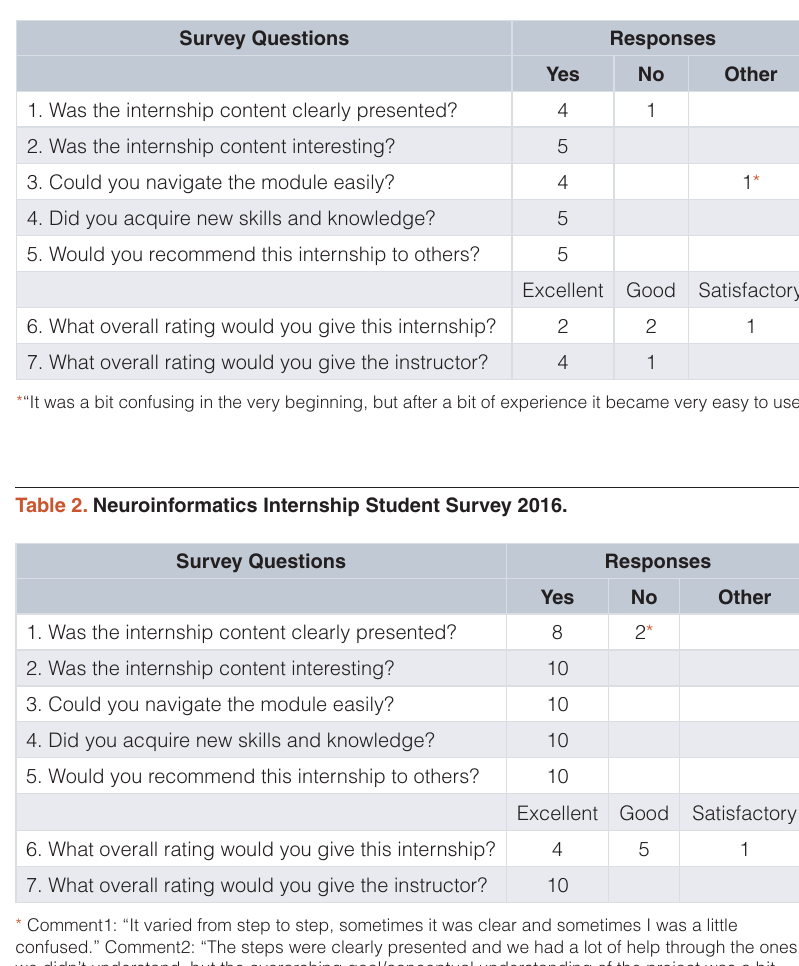
Table 1. Neuroinformatics Internship Student Survey